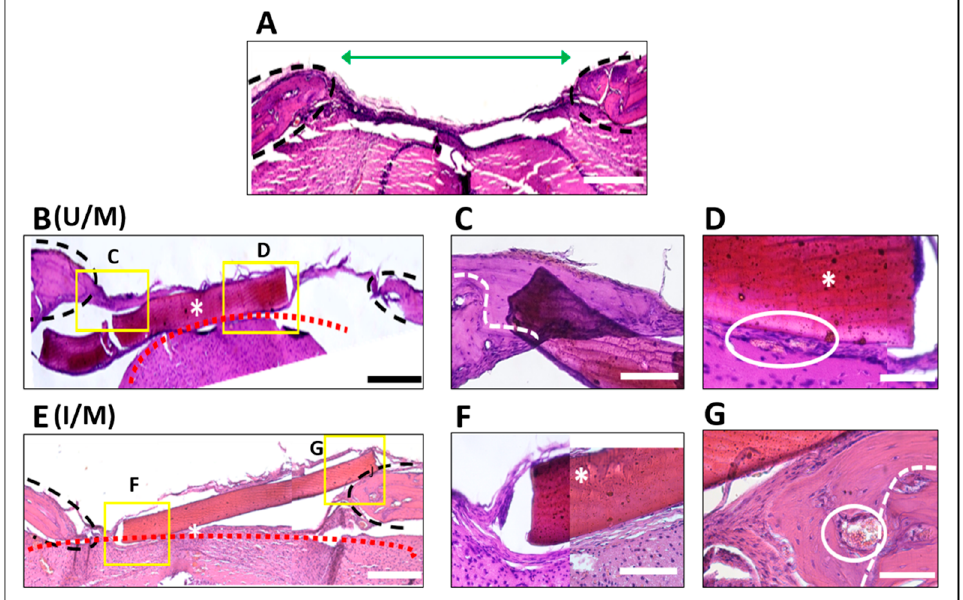
Figure 3. Histological analysis in calvarial defect model. ( A ) Negative control (untreated calvarial defect) green arrow indicates the area of the defect. ( B , E ) correspond to the representative images of the defects treated with membranes unirradiated (U/M) and UV irradiated respectively (I/M). Amplifications of the zones are shown in yellow squares for figure ( B ) (U/M) in ( C , D ). Amplifications of the yellow squares for figure C (I/M) are shown at ( F , G ). The white asterisks indicate membranes. (Figure ( A , B , E ) 4× magnification, 1000 μ m: Figure ( C , D , F , G ) 40× magnification, scale bar 500 μ m).